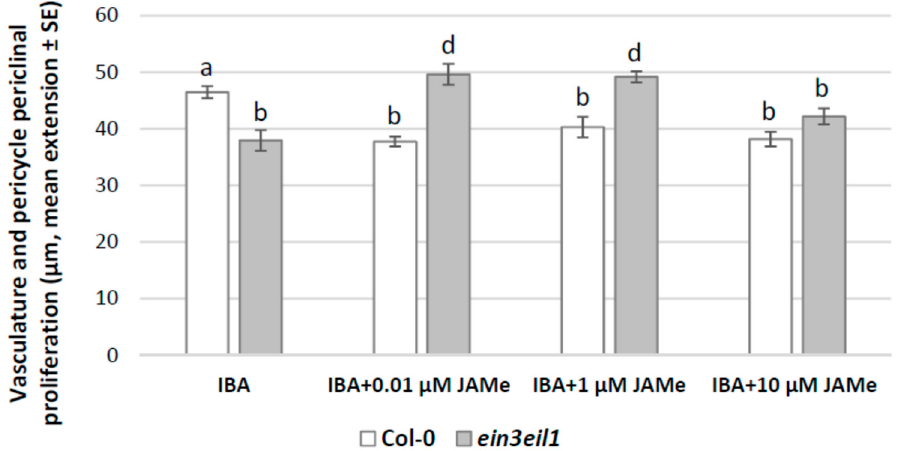
Figure 4. Pericycle periclinal proliferation in the basal hypocotyl of Arabidopsis Col-0 (wt) and ein3eil1 double mutant seedlings either cultured with IBA (10 μ M) or with IBA combined with 0.01, 1 or 10 μ M JAMe. Mean radial extension (± standard error (SE)) of the vasculature plus pericycle periclinal proliferation in the basal 5 mm of the hypocotyls. Different letters among different treatments within the same genotype, or between the two genotypes within the same treatment, indicate significant differences at least at p < 0.05. The same letters indicate no significant difference. Two-way ANOVA followed by Tukey’s post-test. n = 30.